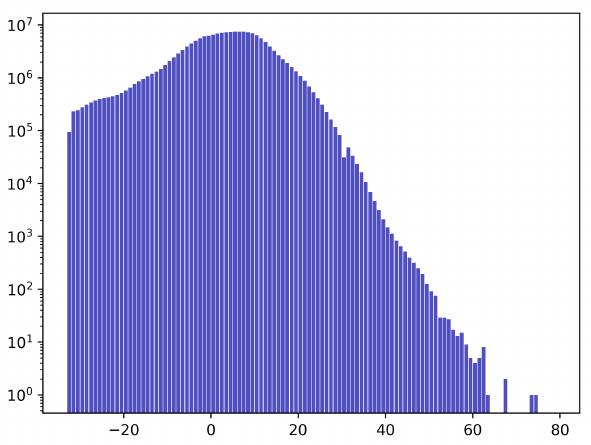
Figure 8. A histogram of the non-missing values in the MET dataset for the entire region and for all acquisitions during a day. A logarithmic scale was used on the OY